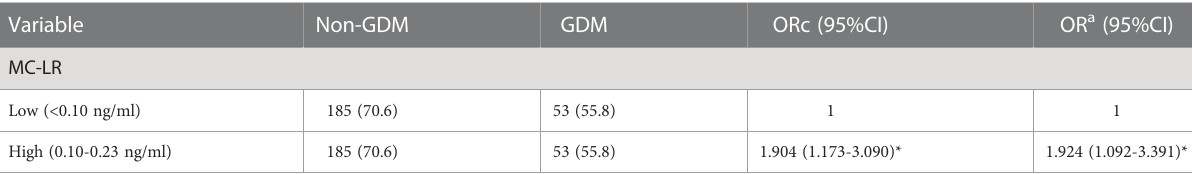
TABLE 2 Logistic regression analysis for GDM in relation to maternal MC-LR.